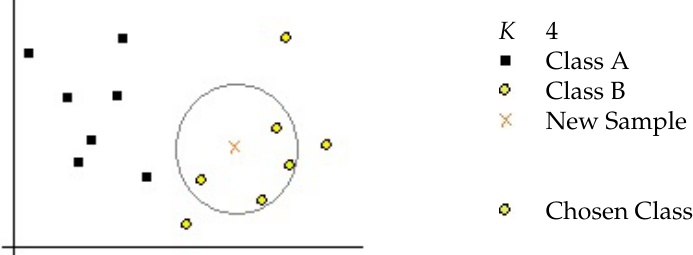
Figure 2. Example of k -Nearest Neighbor (kNN) class